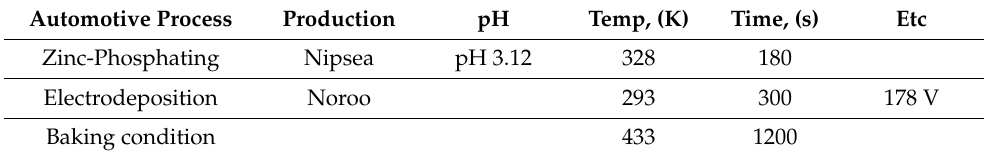
Table 2. The pre-treatment condition of automotive sequential